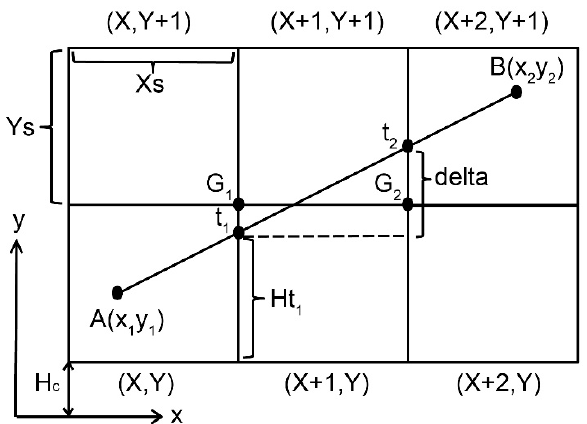
Figure 1. GNSS signal through the pixel in xy-plane; Xs and Ys are the sizes of the pixels; variables X and Y with integers define the position of the pixel; two points A (x 1 , y 1 ) and B (x 2 , y 2 ) define the line AB in the xy-coordinate plane.